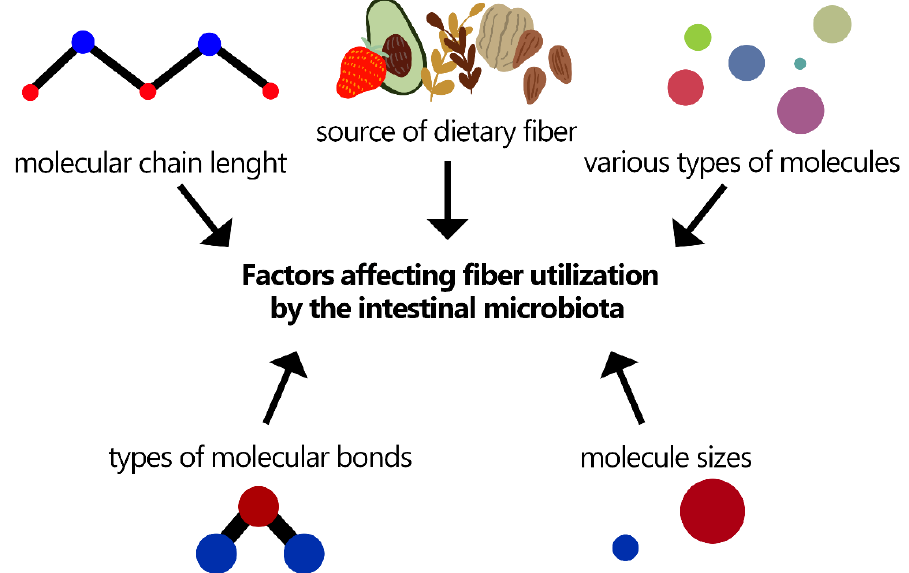
Figure 1. Factors affecting fiber utilization by the intestinal microbiota [37] .